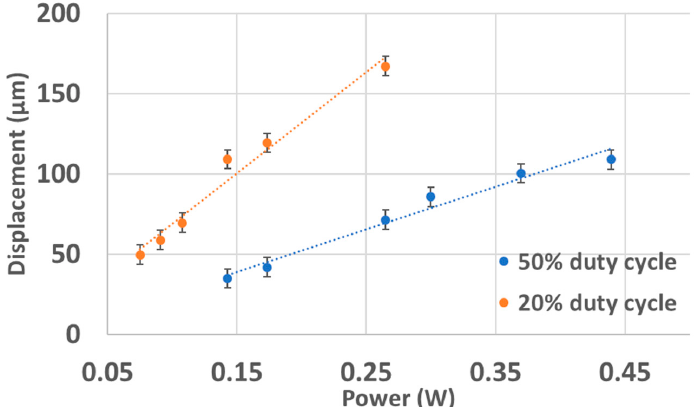
Figure 12. Optical-fiber-tip displacement of the same brass-bridge sample under different pulse duty cycles.